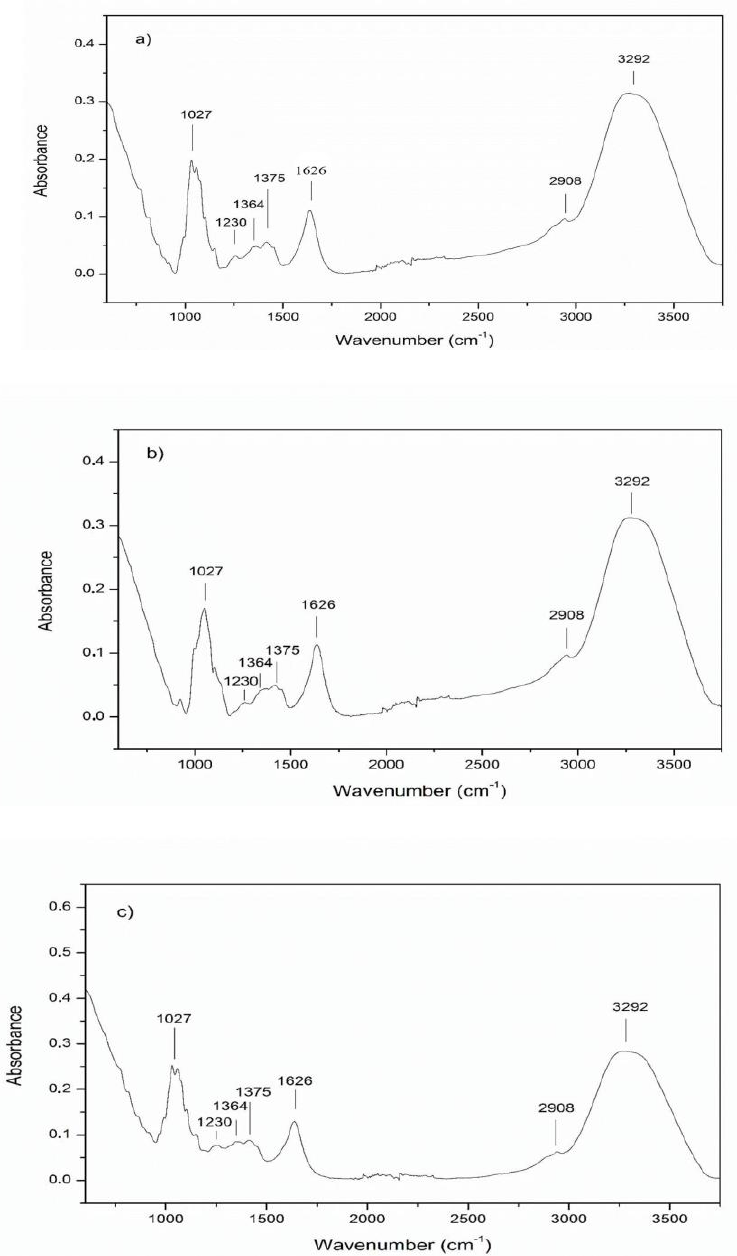
Figure 1. Fourier transform infrared spectroscopy (FTIR) spectra of representative grape ( a ), carob ( b ) and mulberry ( c ) pekmez samples.